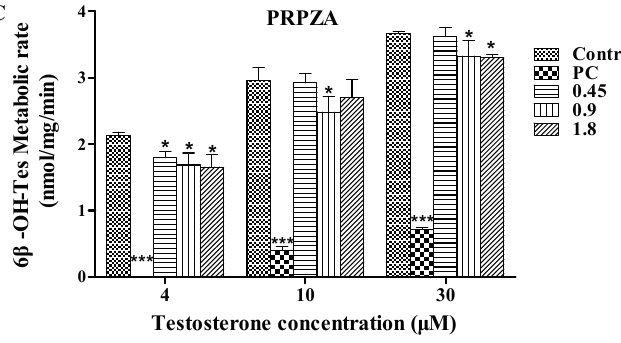
Figure 3. Formation rates of 6 β -hydroxytestosterone (6 β -OH-Tes) from testosterone